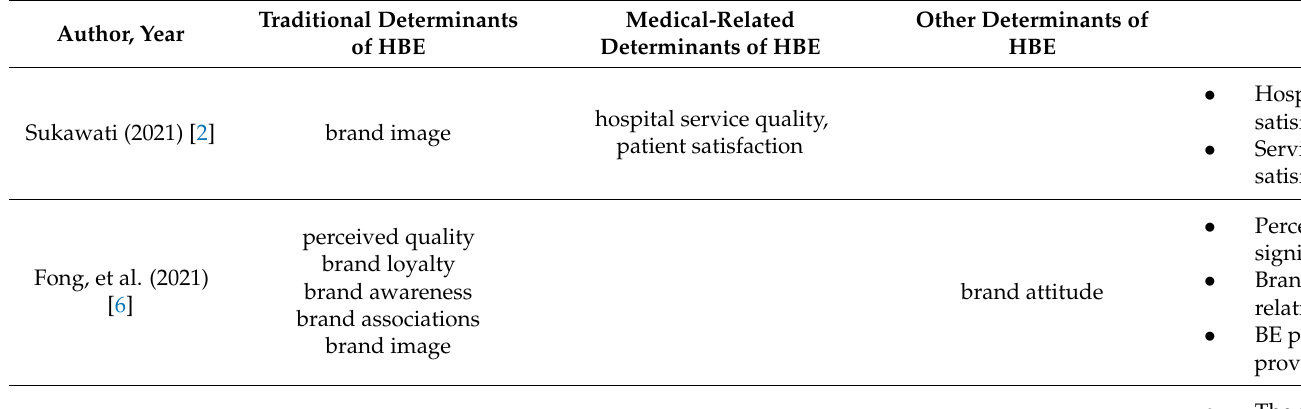
Table 2. Determinants of HBE and key